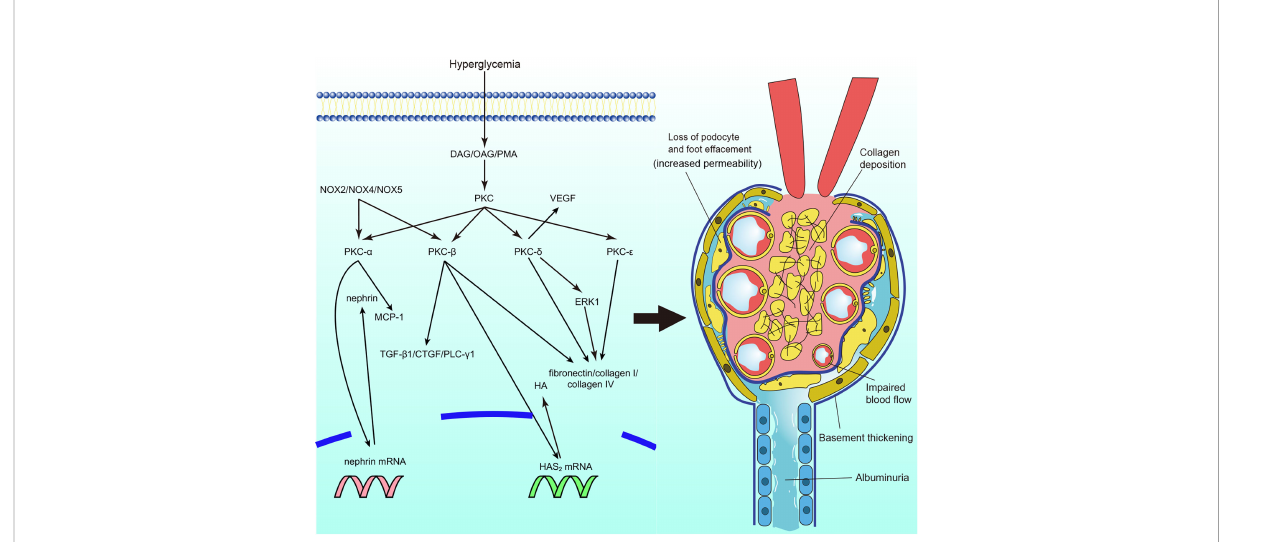
FIGURE 2 Protein kinase C (PKC) in diabetic nephropathy. PKC activation in diabetic nephropathy impairs glomerular blood fl ow and fi ltration, leads to albuminuria, causes extracellular matrix accumulation and collagen deposition particularly. DAG, diacylg lycerol; OAG, oleoyl acetyl glycerol; PKC, protein kinase C; MCP-1, monocyte chemoattractant protein-1; TGF- b 1, transforming growth factor b 1; CTGF, connective tissue growth factor; PLC- g 1, phospholipase C g 1; HAS2, Hyaluronan synthase 2; HA, hyaluronan; ERK, extracellular signal-regulated kinase; VEGF, vascu lar endothelial growth factor; NOX, nicotinamide adenine dinucleotide phosphate